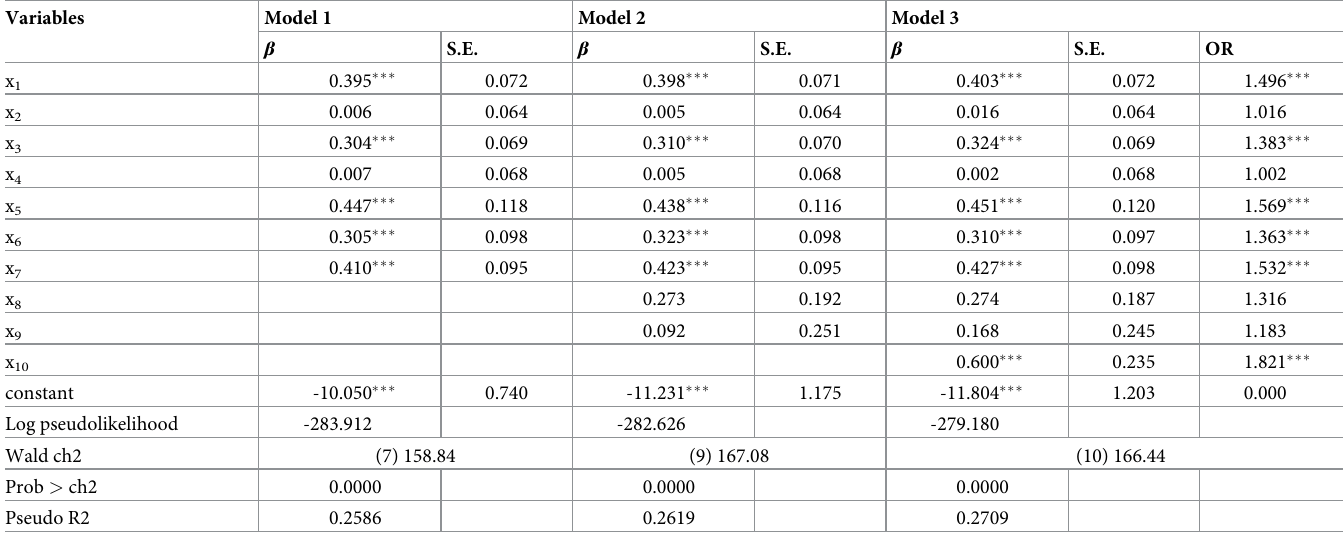
Table 7. Logistic regression for both product and process